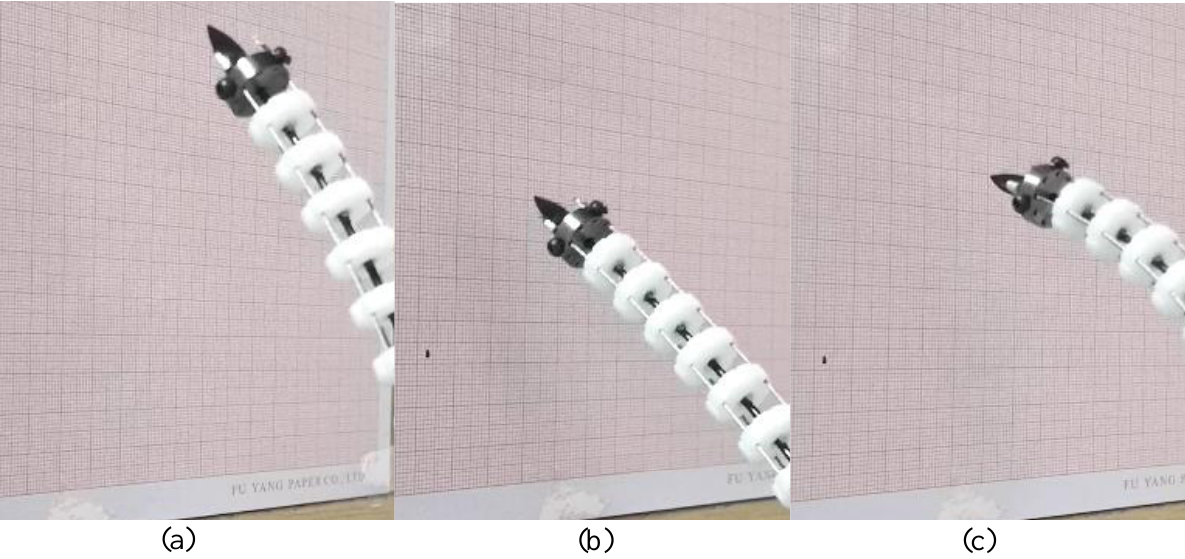
Figure 16. The repeat positioning experiment of the single arm. ( a ) Before marking, ( b ) The 5th marking, ( c ) The 10th marking.